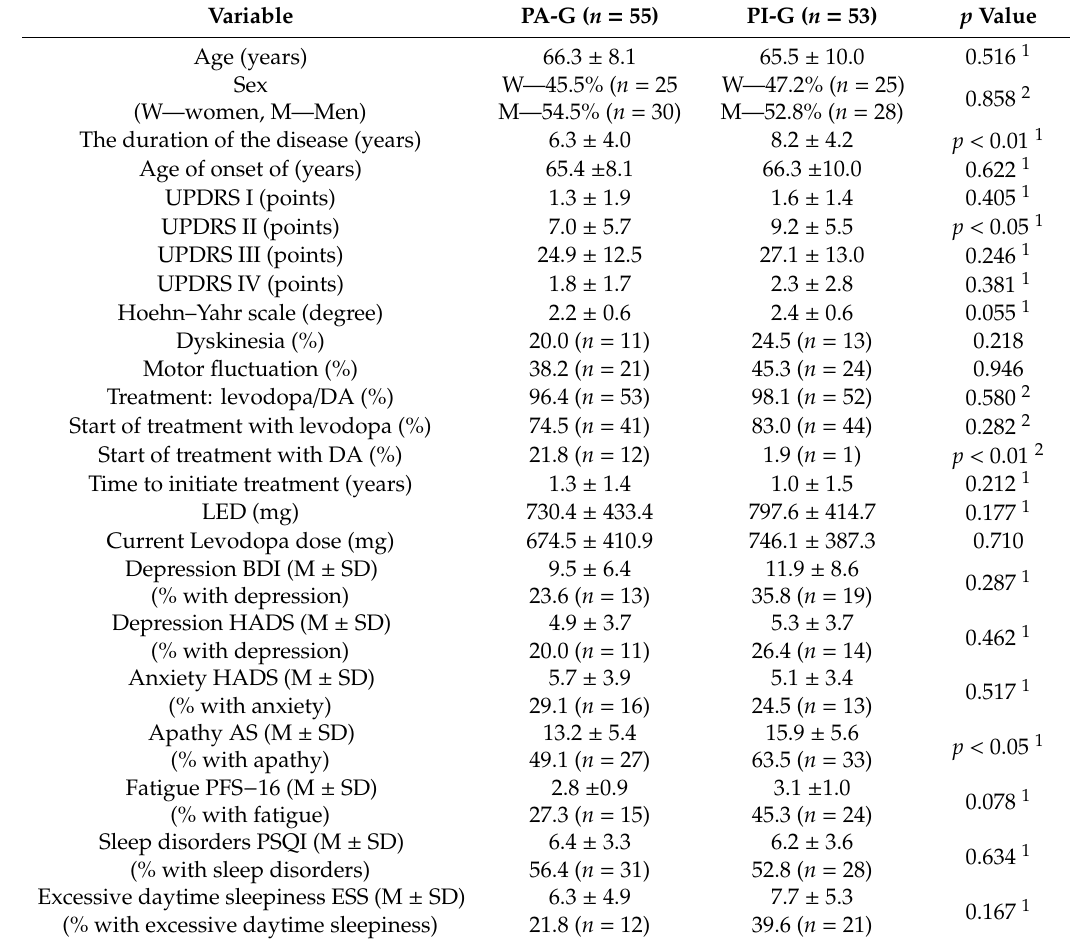
Table 2. Characteristics and results of the physically active and physically inactive